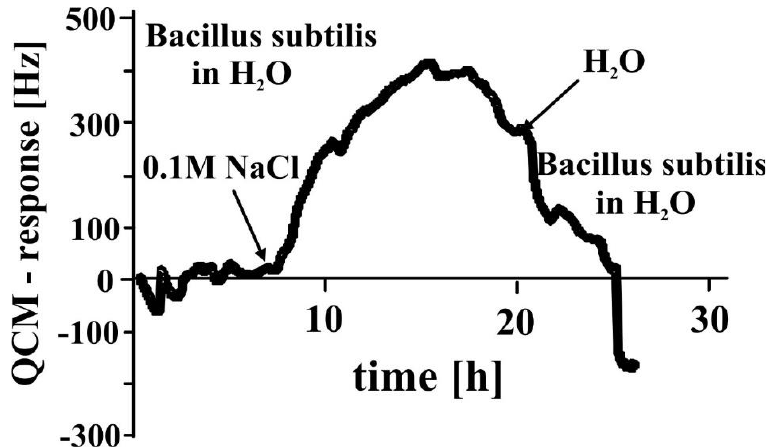
Figure 7. Bacillus subtilis adhered tightly to polyurethane coating exhibits osmotic effects on electrolyte addition.